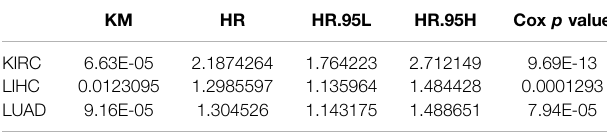
TABLE 1 | CCNA2 associated with poor OS by the Kaplan – Meier survival curve and log-rank test. KM